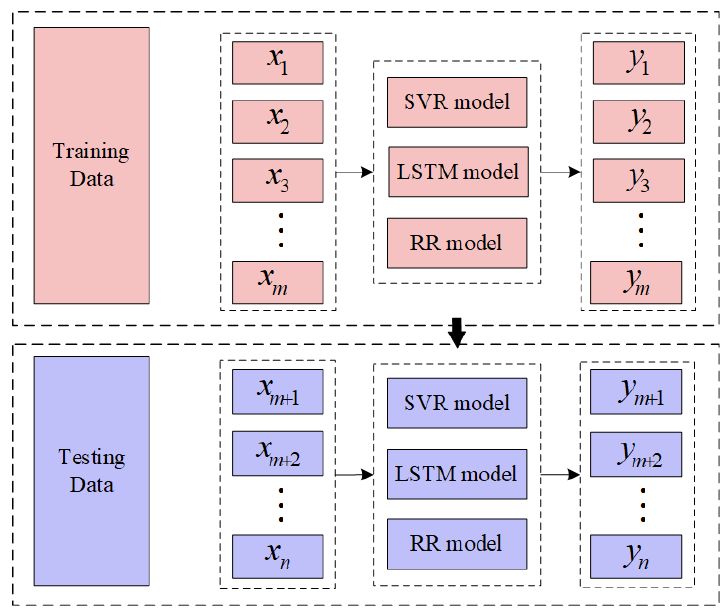
Figure 5. Training and test process with different prediction